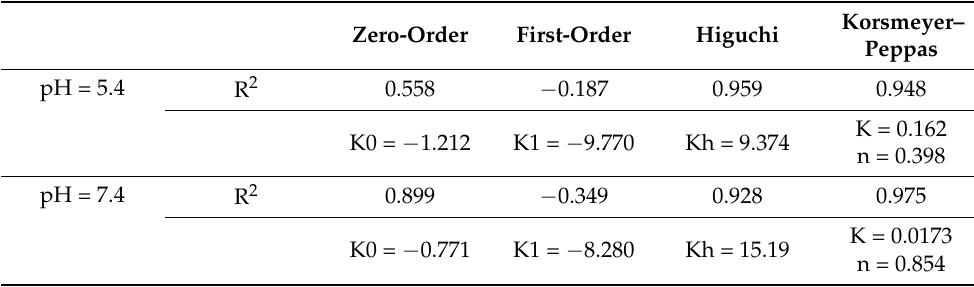
Table 7. The kinetic models’ parameters and correlation coefficients for estimating the release of CUR from PVA/GO-Ag-CUR nanofiber in pH 5.4 and pH 7.4. Korsmeyer– Zero-Order First-Order Higuchi